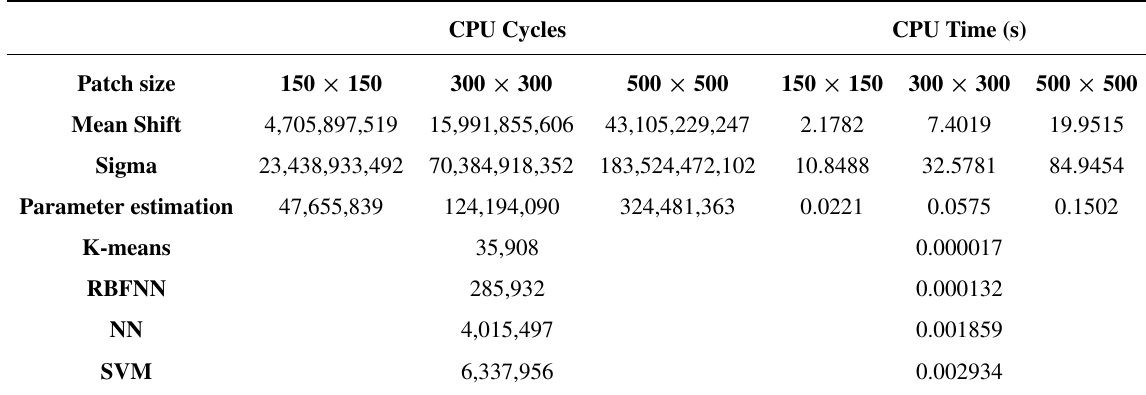
Table 11. Number of CPU cycles and CPU time for the filtering algorithms, the statistical parameters estimation and the classification algorithms depending on the patch size. CPU time is calculated with an average CPU speed of 2 . 1605 × 10 9 cycles/s. CPU